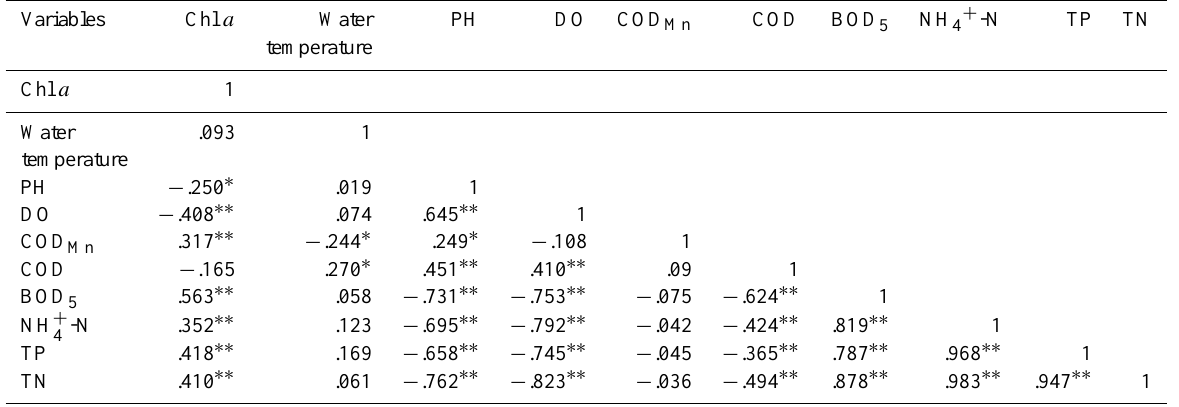
Table 1. Correlation coefficients between the environmental variables in Dianchi Lake (Pearson, two-tailed).